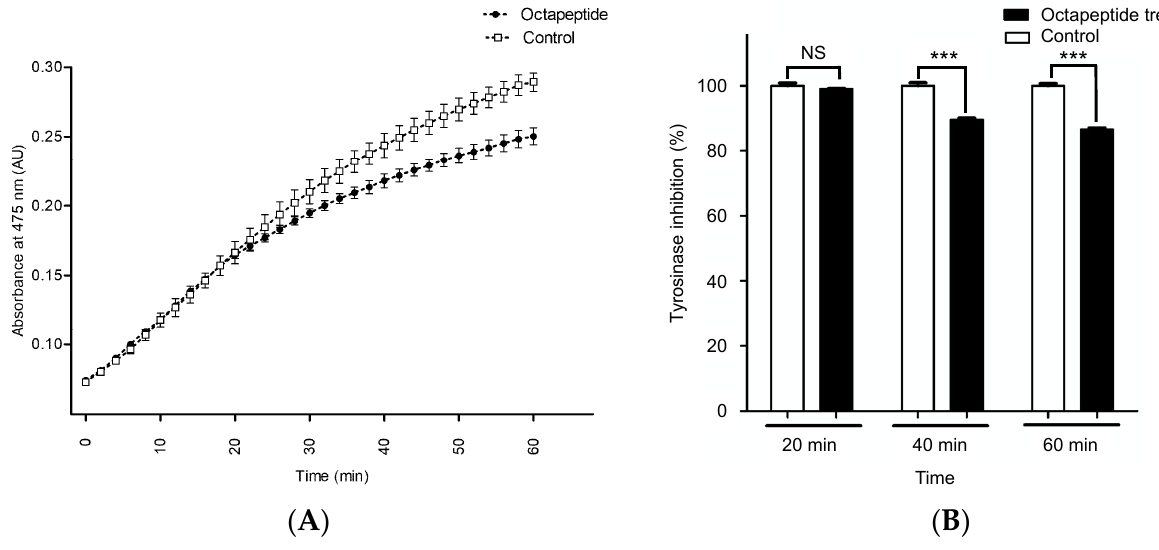
Figure 2. The in vitro tyrosinase activity inhibition. ( A ) The inhibitory effect of 0.05 mg/mL octapep- tide on tyrosinase in a time-dependent manner. (•) and (o) represent the octapeptide and control groups, respectively. ( B ) The endpoint inhibition (at 60 min) of the octapeptide on the tyrosinase activity. Clear and solid bars represent the control and octapeptide groups, respectively. Data were represented as mean ± SD from triplicate results. Asterisks (***) indicate the significance levels of p < 0.001 and NS, not significant.